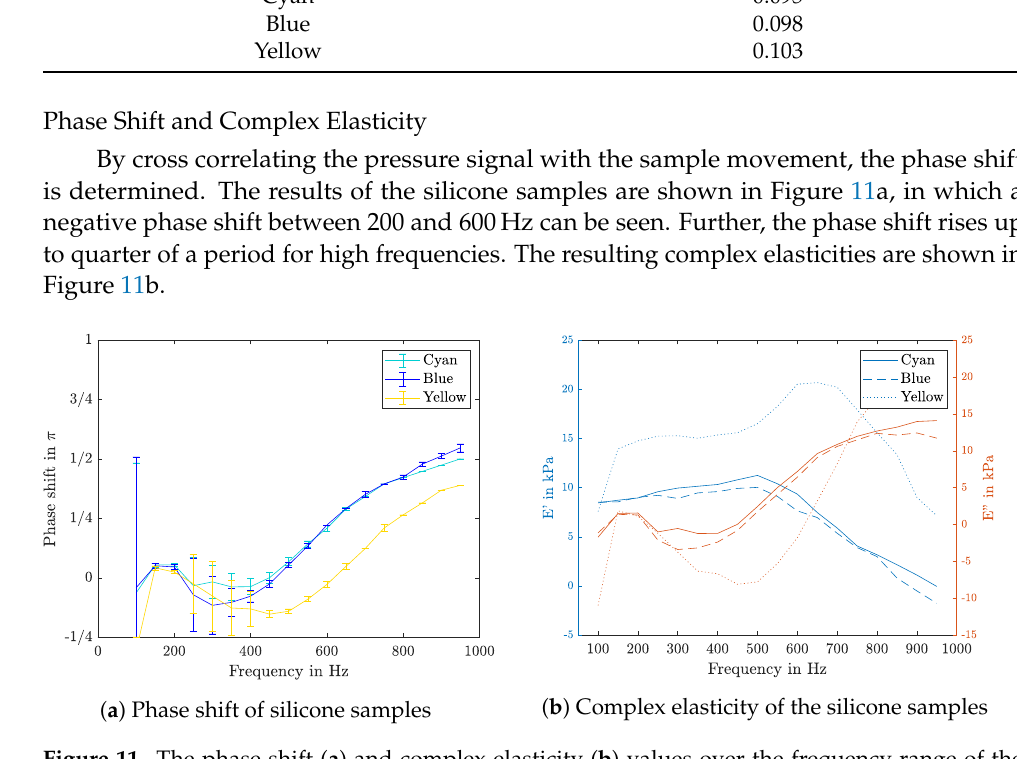
Figure 11. The phase shift ( a ) and complex elasticity ( b ) values over the frequency range of the different silicone